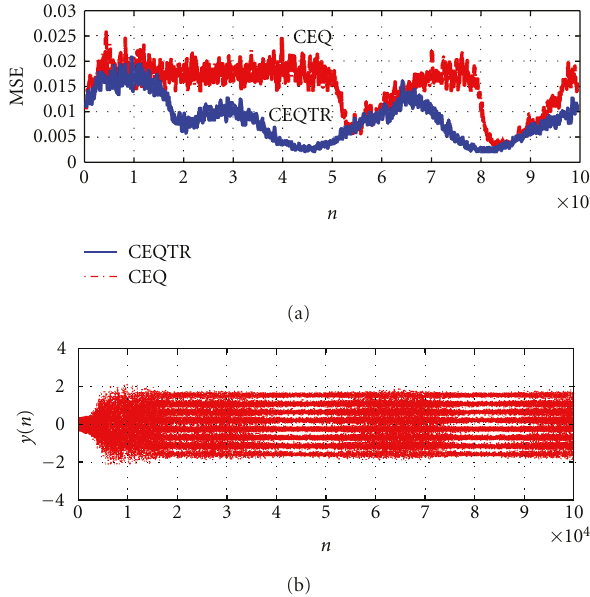
Figure 3: Curves with simulation parameters as in Figure 2. (a) CEQ and CEQTR output MSE. (b) CEQTR output y corresponding to (a) MSE